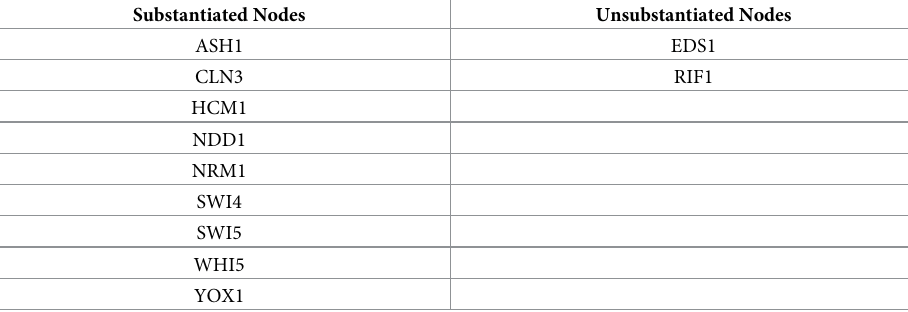
Table 5. The list of 9 substantiated and 2 unsubstantiated yeast cell cycle